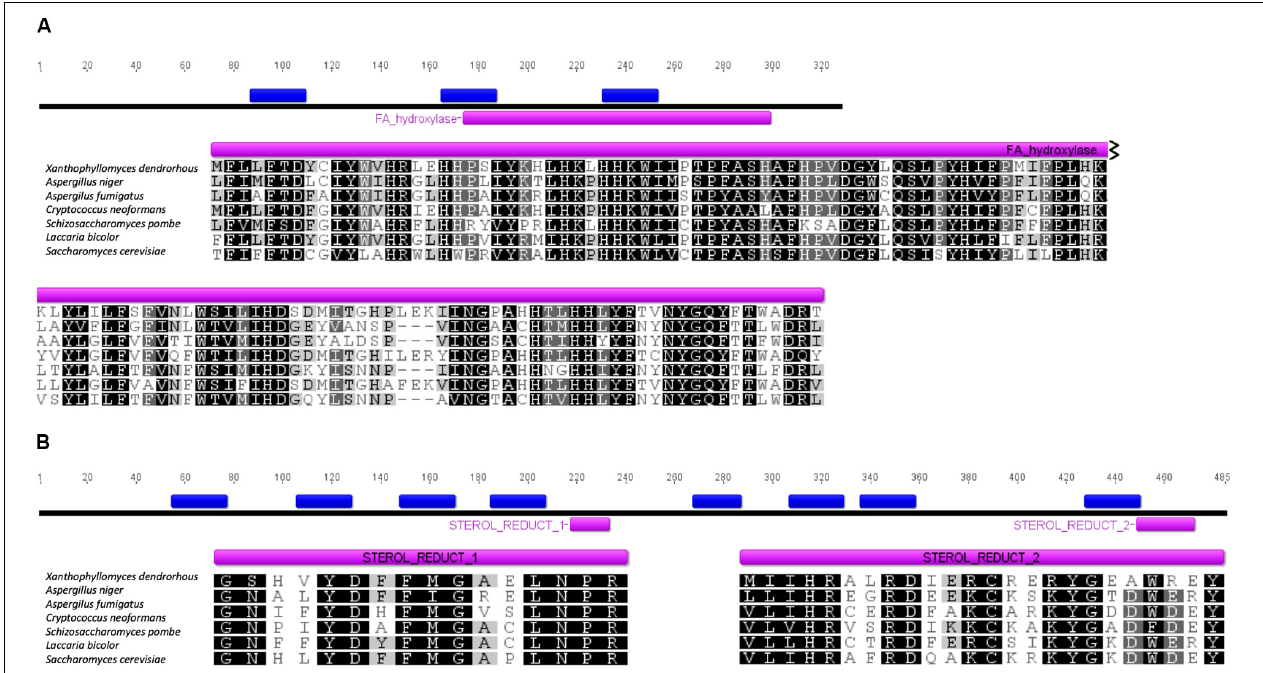
FIGURE 2 | Sequence analysis of the X. dendrorhous Erg3 and Erg4 predicted proteins. (A) Representation of the deduced Erg3 protein and sequence alignment of the sterol desaturase/sphingolipid hydroxylase, fatty acid hydroxylase superfamily (FA_hydroxylase; COG3000) domain (residues 174 to 299 of the X. dendrorhous Erg3 protein). (B) Representation of the deduced Erg4 protein and sequence alignment of the two identified sterol reductase (Sterol_Reduct_1 and 2; PS01017 and PS01018) domains (residues 218 to 233 and 449 to 472 of the X. dendrorhous Erg4 protein). Predicted transmembrane segments are represented in blue boxes. The UniProt accession numbers (Erg3; Erg4) of sequences used in the alignments are Aspergillus niger (A0A100II78_ASPNG; A0A254U2Z2_ASPNG), Aspergillus fumigatus (Q2VWQ7_ASPFM; Q4WKA5_ASPFU), Cryptococcus neoformans (Q5KNX1_CRYNJ; Q6U7Q6_CRYNH), Schizosaccharomyces pombe (ERG31_SCHPO; STS1_SCHPO), Laccaria bicolor (B0DA59_LACBS; B0CTW1_LACBS) and Saccharomyces cerevisiae (P32353; P25340). Alignments are colored by percentage identity as follows: black 100% identity, gray > 80% identity, light gray > 60% identity and white < 60%